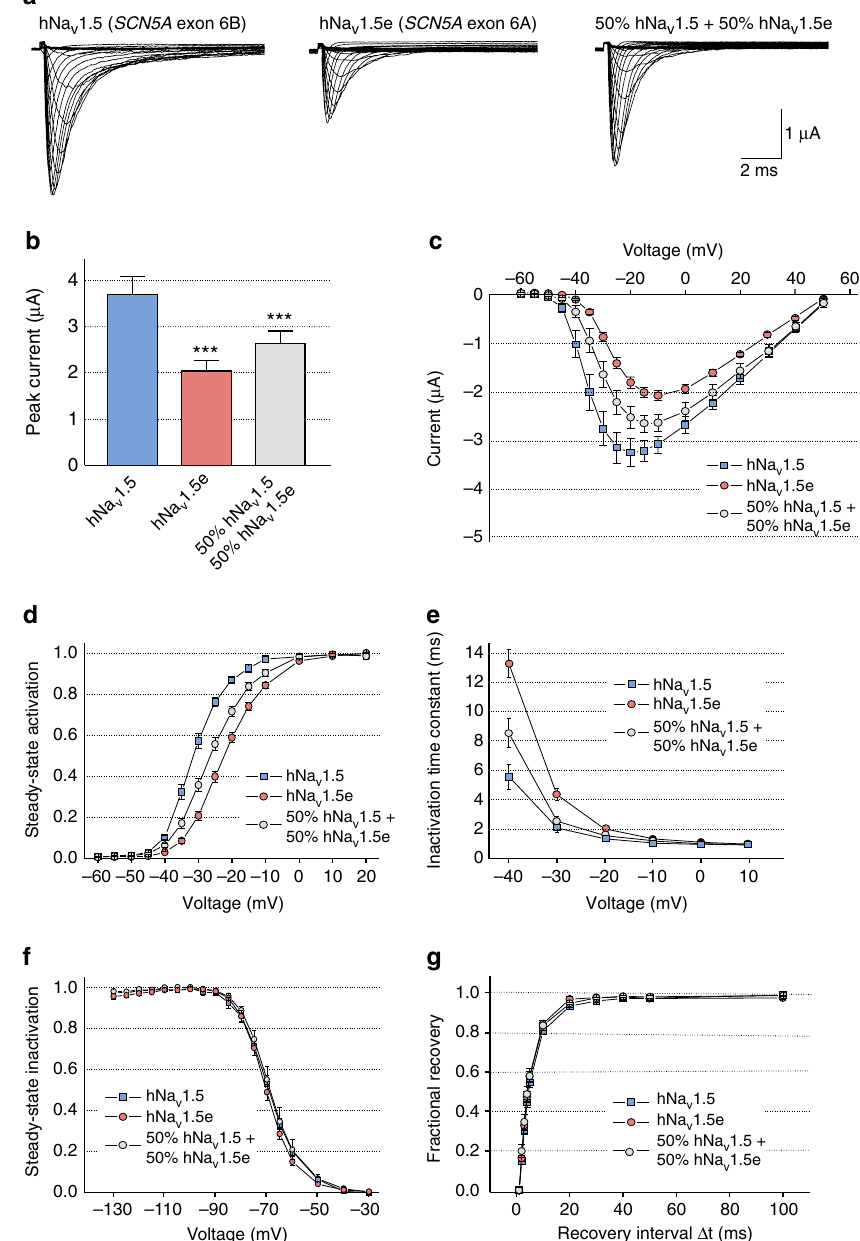
Figure 5 | Electrophysiological properties of hNa v 1.5 and hNa v 1.5e channels. ( a ) Representative Na þ currents generated in Xenopus oocytes by hNa v 1.5 (encoded by SCN5A containing the adult exon 6B), hNa v 1.5e (encoded by SCN5A including the fetal exon 6A), and simultaneously expressed Na v 1.5 and Na v 1.5e channels at a 1:1 ratio. ( b ) Peak current amplitudes at the test potential of (cid:2) 10mV in Xenopus oocytes injected with equimolar amount of cRNA encoding hNa v 1.5, hNa v 1.5e or 1:1 combination of Na v 1.5 and Na v 1.5e channels. ( c ) Current–voltage relationships. ( d ) Steady-state activation curves. ( e ) Inactivation time constants t h (ms) at different test pulses. ( f ) Steady-state inactivation curves. ( g ) Fractional recovery curves. Data were obtained from 11 different batches of oocytes. To illustrate steady-state activation, steady-state inactivation and recovery from inactivation, we used 3–5 representative measurements. For total number of measurements ( n ¼ 25–27) and for statistical data evaluation (Vm, s) see the Supplementary Table 2. Bars indicate s.e.m. Student test, *** indicates P o